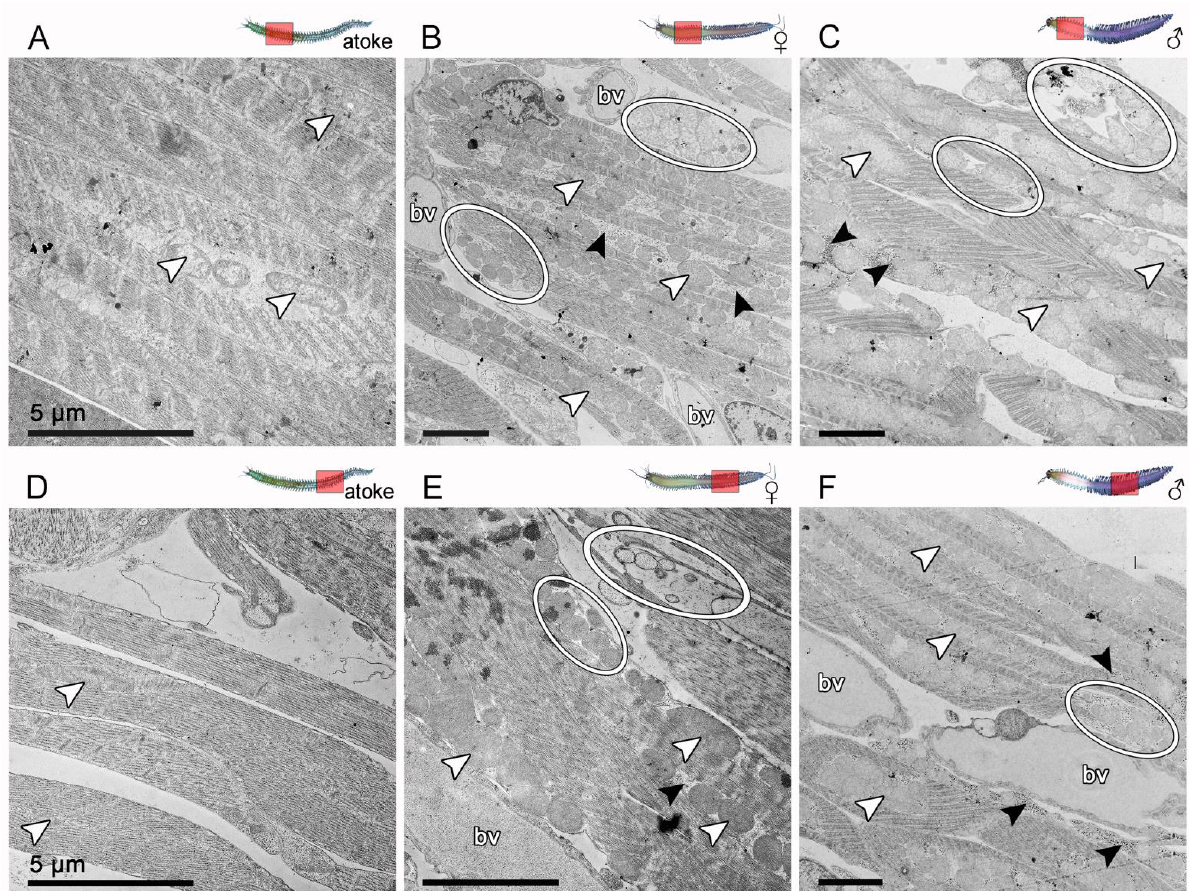
Figure 5. Sexual maturation similarly affects the ultrastructure of transversal muscles along the body axis in transmission electron microscopy (TEM). ( A – F ) Ultrastructure of transversal muscles revealed by TEM. Transversal muscles in ( A , D ) in atokous, ( B , E ) in female epitokous, as well as ( C , F ) in male epitokous animals in ( A – C ) anterior and ( D – F ) posterior-located segments. ( A , D ) Atokous tm in the muscle fibers show a clearly pronounced contractile apparatus and only single mitochondria, which are located in the central part of the fibers (white arrowheads). ( B , C ) After maturation, the contractile elements of the anterior tm lie on either side of the strongly multiplicated mitochondria (white arrowheads). In some muscles, the contractile apparatus is stronger reduced (circles) and accompanied by an accumulation of glycogen grains (black arrowheads). In addition, an overall growth of blood vessels (bv) is detectable. ( E , F ) The ultrastructural changes in the tm fibers of the posterior segments are similar to those of the anterior segments, except for the greater increase in blood vessels (bv). Abbr.: bv vessel. Scale bars = A – F 5 µm.